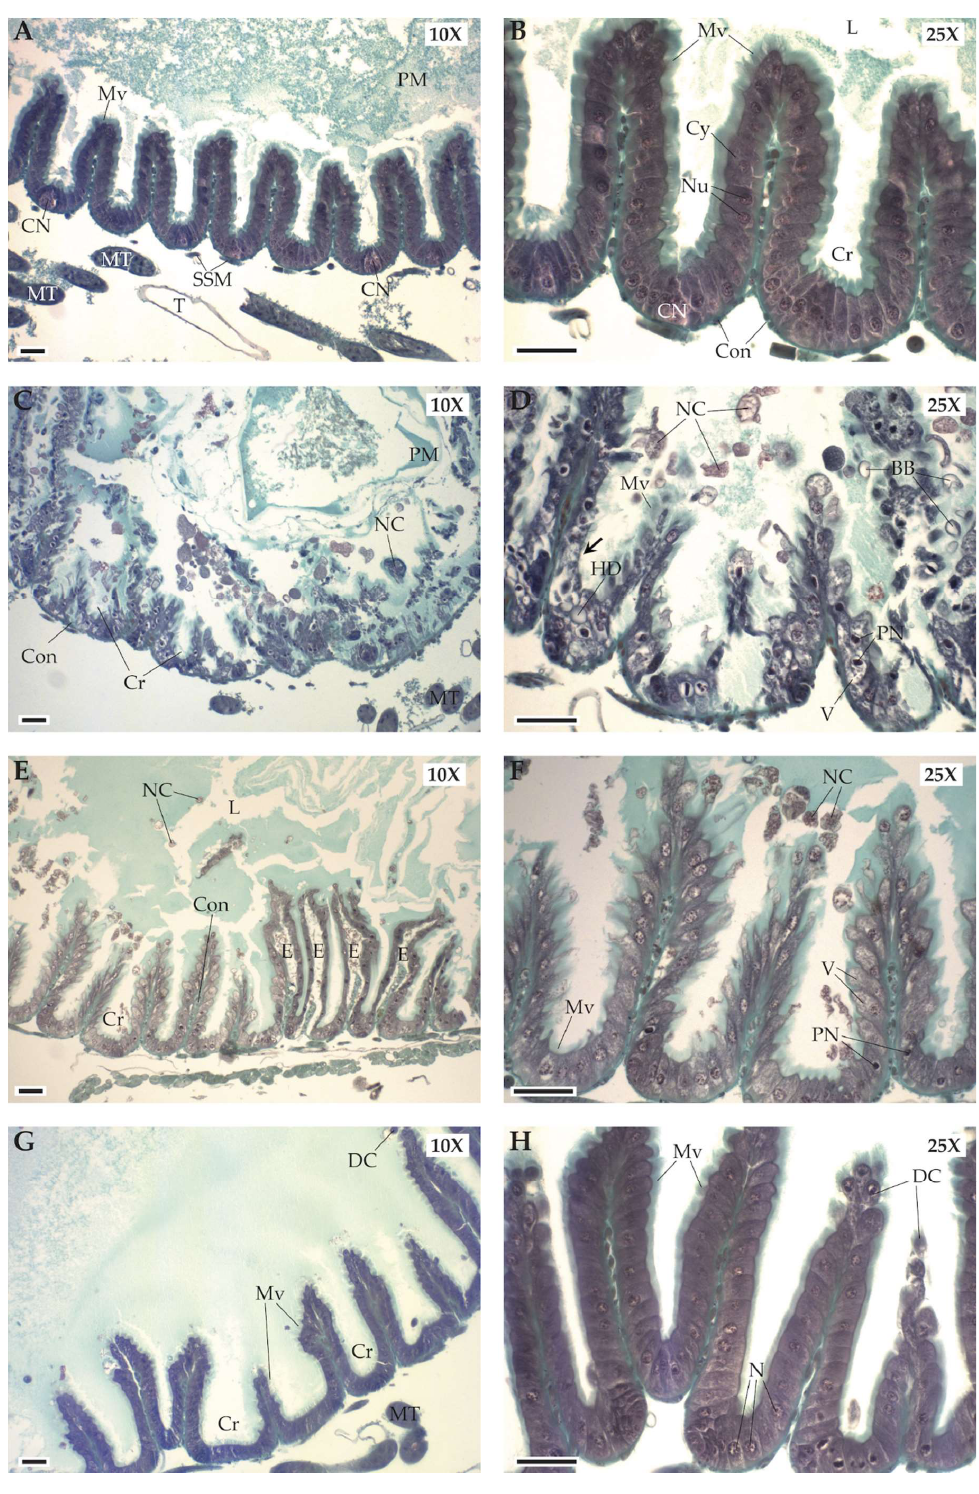
Figure 4. Digestive tracts of the bumblebee workers exposed to the natural Taraxacum treatment ( A , B ), the crushed Taraxacum treatment ( C , D ), the phystosterol treatment ( E , F ), and the lactone treatment ( G , H ). BB: cytoplasmic blebbing; E: interstitial edema; CN: cellular nidi; Con: connective tissue; Cr: intestinal crypt; Cy: granular cytoplasm of digestive cell; DC: detached cells; HD: hydropic degeneration; L: lumen; MT: Malpighian tubules, Mv: microvilli; NC: necrotic cells; Nu: nucleus; PN: pyknotic nuclei; SSM: striated skeletal muscle; T: tracheal system; V: cytoplasmic vacuolization. The arrow indicates the loss of the brush-like border. Scale bar, 50 µ